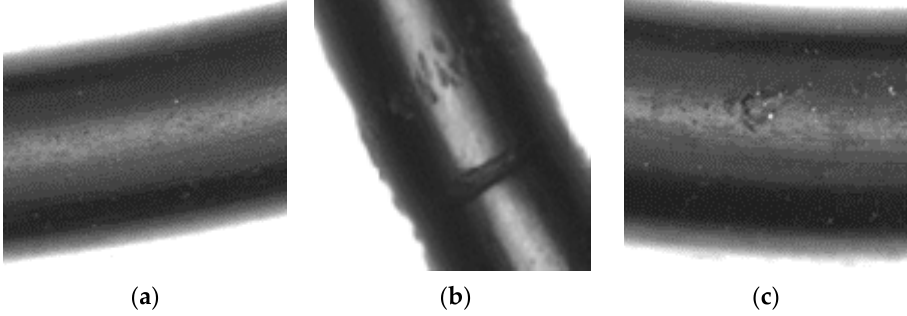
Figure 2. ( a ) Sample without defects; ( b ) sample with flow marks; ( c ) sample with non-fills.